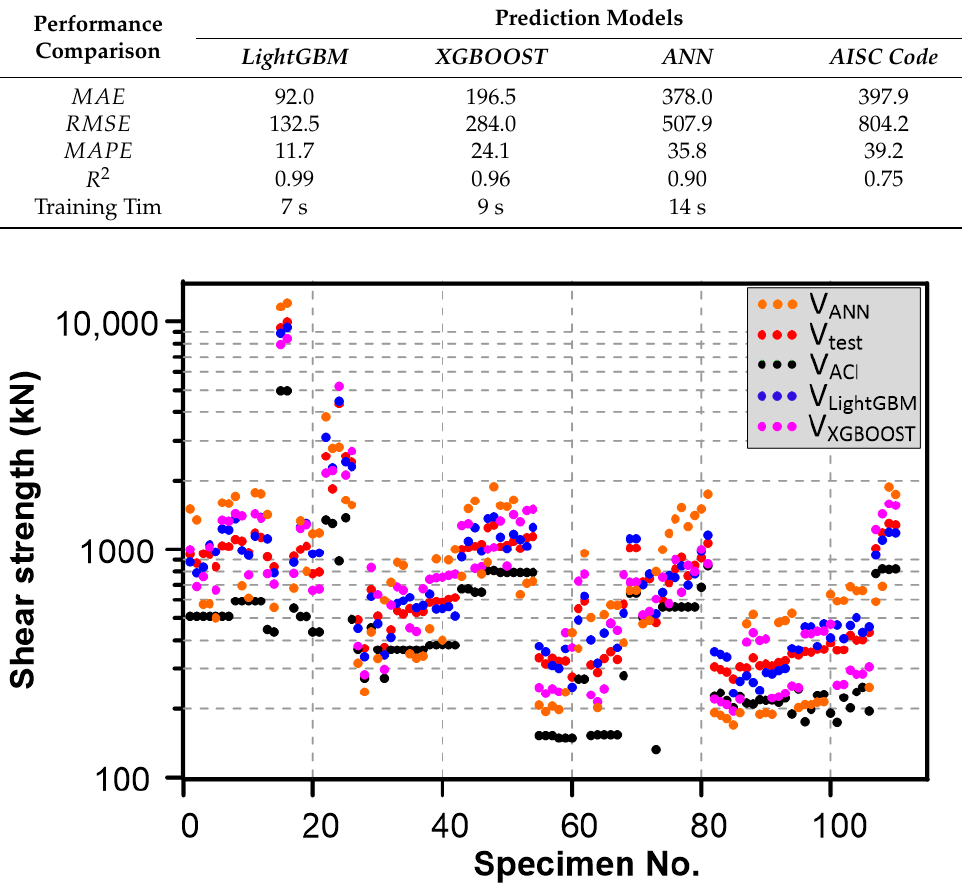
Figure 8. Model’s prediction comparison with experimental strength.